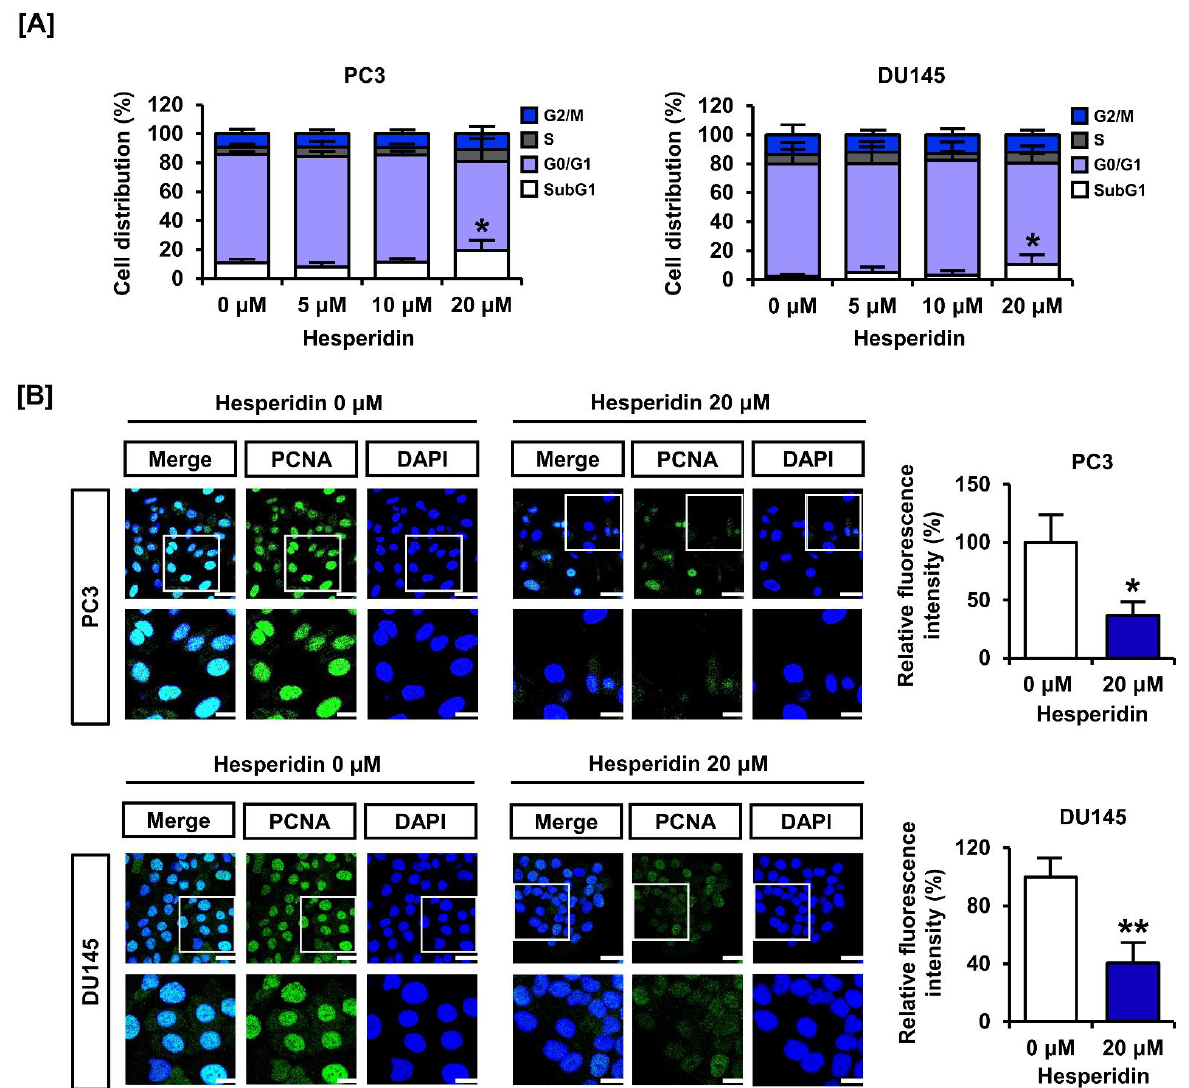
Figure 2. Effect of hesperidin on the cell cycle arrest of prostate cancer cells. ( A ) Cell cycle distribution was analyzed after dose-dependent treatment of PC3 and DU145 cells with hesperidin via flow cytometry. ( B ) The ability of hesperidin to regulate the expression of proliferating cell nuclear anti- gen (PCNA) was analyzed via immunofluorescence using Alexa 488 (green). Then, 4, 6-diamino-2- phenylindole (DAPI; blue) was used to stain the nuclei of PC3 and DU145 cells. Scale bars of the first horizonal panels are 40 μm, and scale bars of the second horizonal panels are 20 μm. All results of the arithmetic mean ( n = 3) denote statistical significance with asterisks (* p < 0.05 and ** p < 0.01).